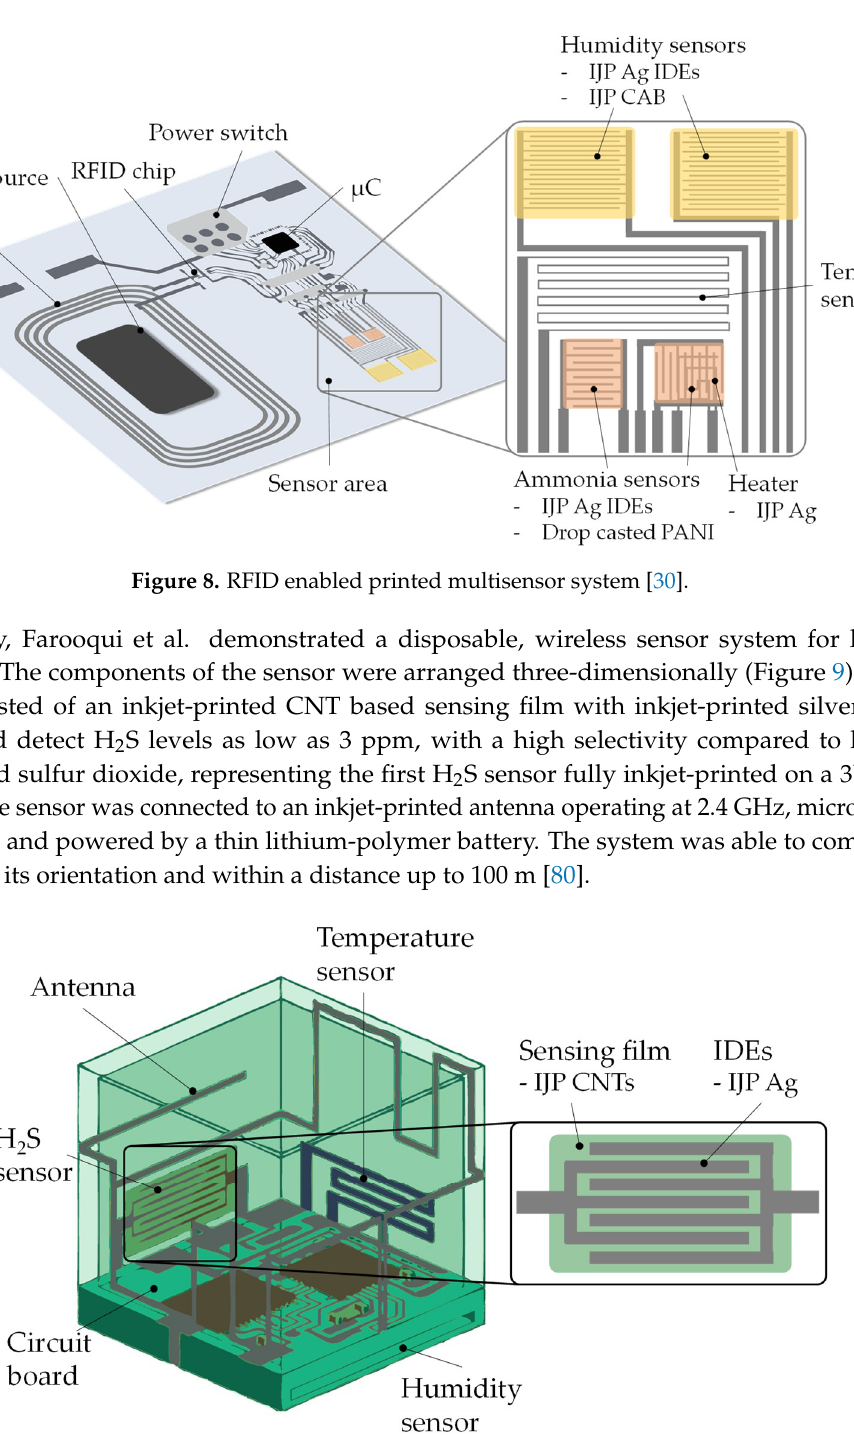
Figure 9. 3D wireless sensor system for large distance environmental monitoring [80].